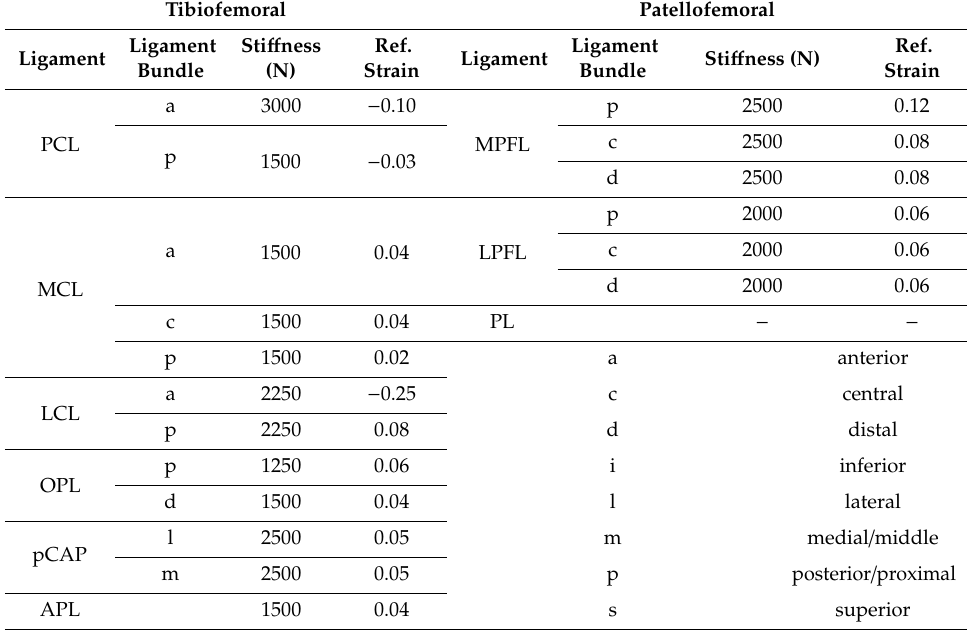
Table A1. Mechanical properties (sti ff ness and reference strain) of the implemented ligaments were adapted from the literature [60,61,74,80]. The tibiofemoral ligament structures included: two bundles posterior cruciate ligament (PCL), two bundles lateral collateral ligament (LCL), three bundle medial collateral ligament (MCL), two bundles oblique popliteal ligament (OPL), one bundle arcuate popliteal ligament (APL), two bundles posterior capsule (pCAP), three bundles lateral patellofemoral ligament (LPFL), three bundles medial patellofemoral ligament (MPFL), and the patellar ligament (PL). Reference strains are the respective ligament strain values for the reference position upright standing. Sti ff ness is expressed in Newton per unit